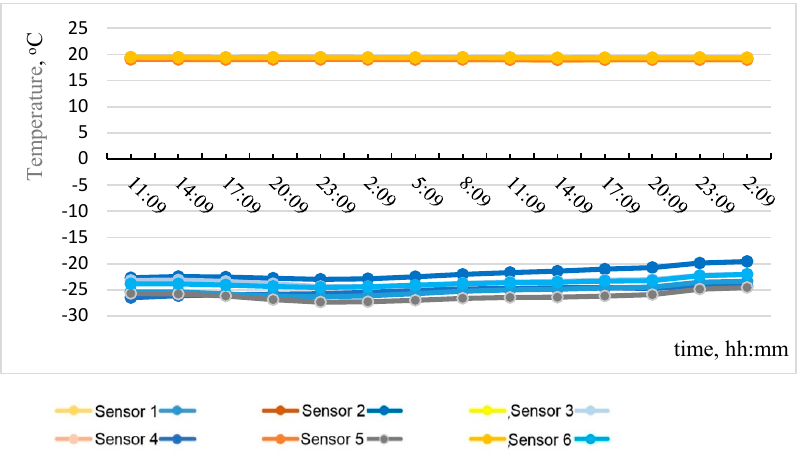
Figure 13. Temperature on the specimen No. 2 surface with time.